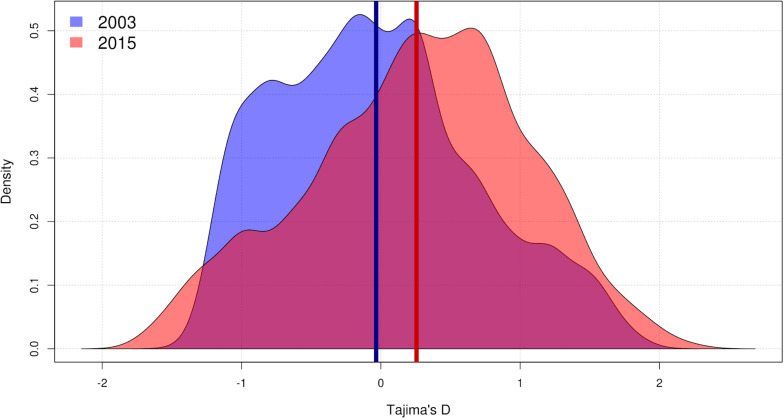
Density plot of the distribution of Pseudomonas otitidis Tajima’s D at core genome level. Samples of P. otitidis from 2003 and 2015 consist of 5 and 7 individuals, respectively. 3503 genes were used for the analysis due to the rest of the 3682 global core lacking any variation to measure. Kernel smoothing was used to plot the values. Vertical bars represent the means: –0.03 in 2003 (blue, left-skewed) and 0.26 in 2015 (red, right-skewed). The increase in mean value and the increase in variance are significant (paired two-sided Wilcoxon test: V = 2.07e6, p < 0.001; Lavene’s test: F(1,7004) = 23.8, p < 0.001).